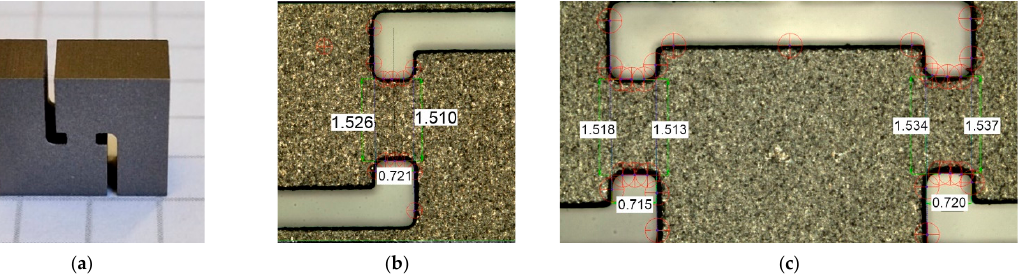
Figure 2. Quality of sample cutting using the WEDM technology: ( a ) General view of SSS specimen; ( b ) dimensional control of shear zone of SS specimen; ( c ) dimensional control of shear zones of D2S specimen.